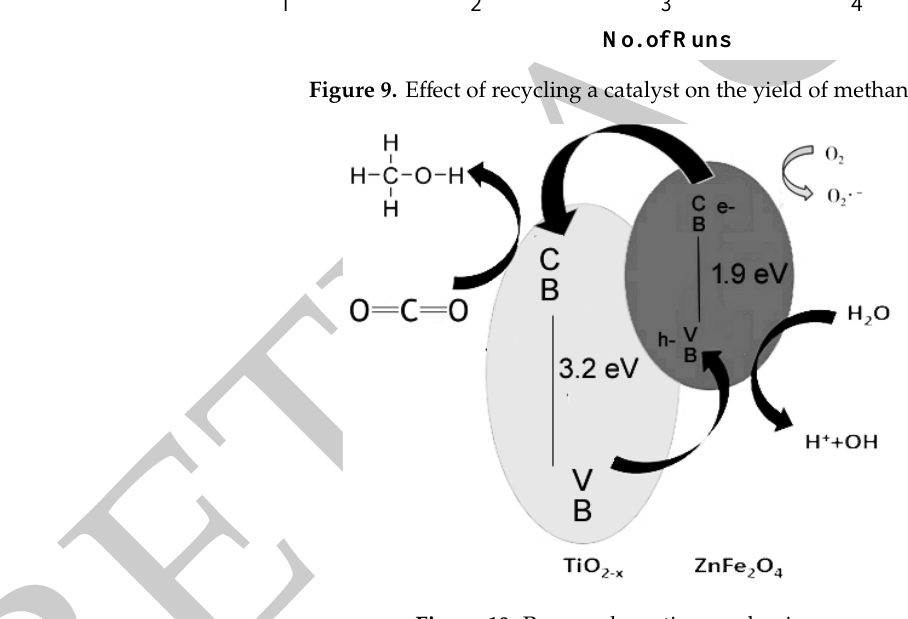
Figure 9. Effect of recycling a catalyst on the yield of methanol.